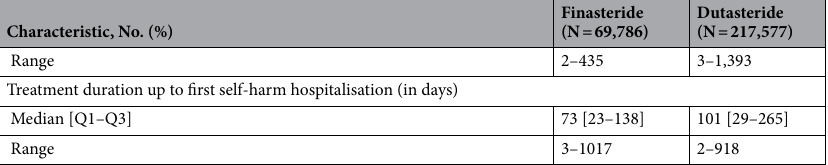
Table 1. Baseline characteristics of individuals included in the groups treated with finasteride or dutasteride. *Self-harm with a violent means defined by an ICD-10 code (X66-X83). HIV/AIDS: human immunodeficiency virus infection; acquired immunodeficiency syndrome. [Q1-Q3]: first and fourth quartiles.